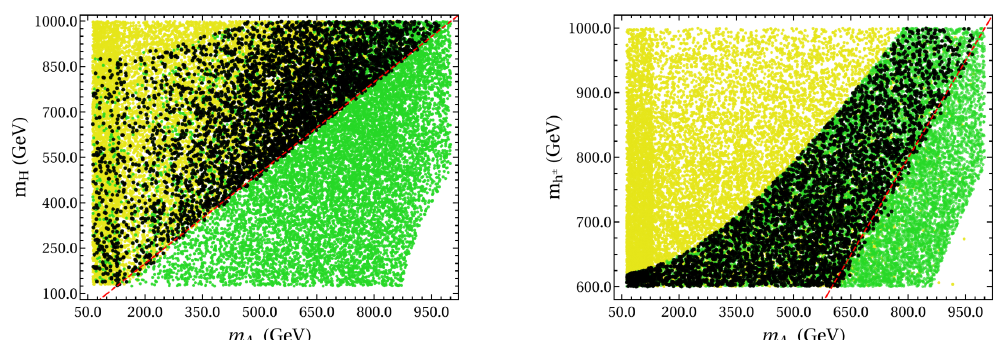
Figure 4 . In both figures, the yellow points comply with the stabiltiy bound, the green points with perturbativity and unitarity, while the black points comply with all theoretical constraints. The dashed red line is for degenerate